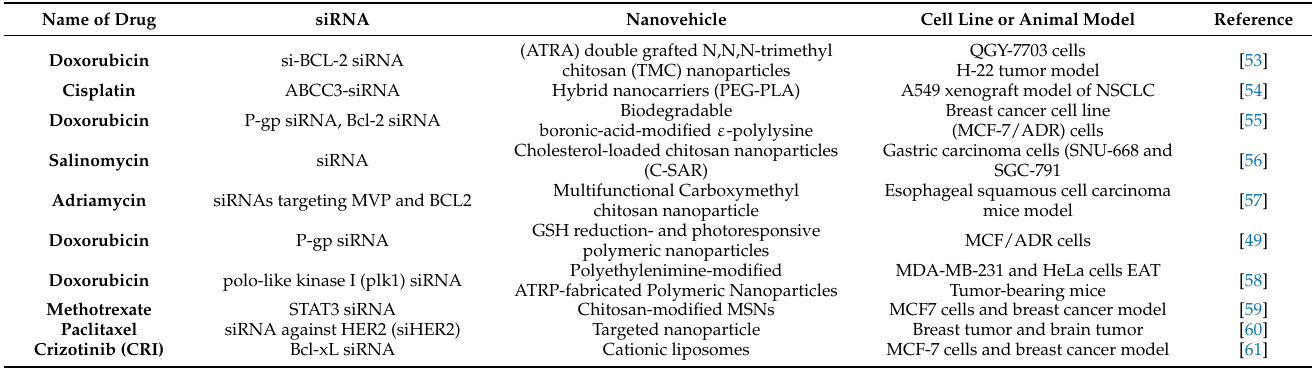
Table 1. Co-delivery of chemotherapeutic drug and siRNA using different